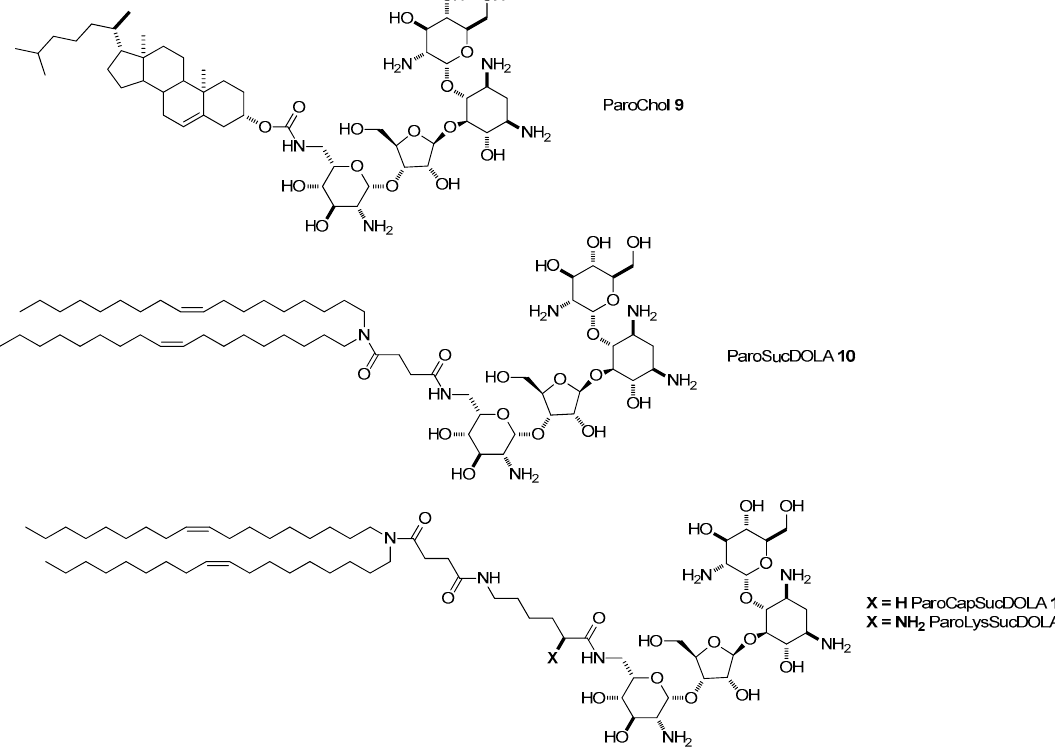
Figure 6. Synthesis of neomycin-based lipids 14 , 15 : (i) Boc 2 O, TEA, DMF/H 2 O, (ii) TIBS-Cl, pyridine, (iii) 2-aminoethanethiol, EtONa/EtOH, (iv) cholesteryl chloroformate, TEA, THF/DMF, (v) TFA/DCM, (vi) N -succinyl-dioleylamine, HOAt/EDC, DFM/DCM, (vii) TFA/DCM.